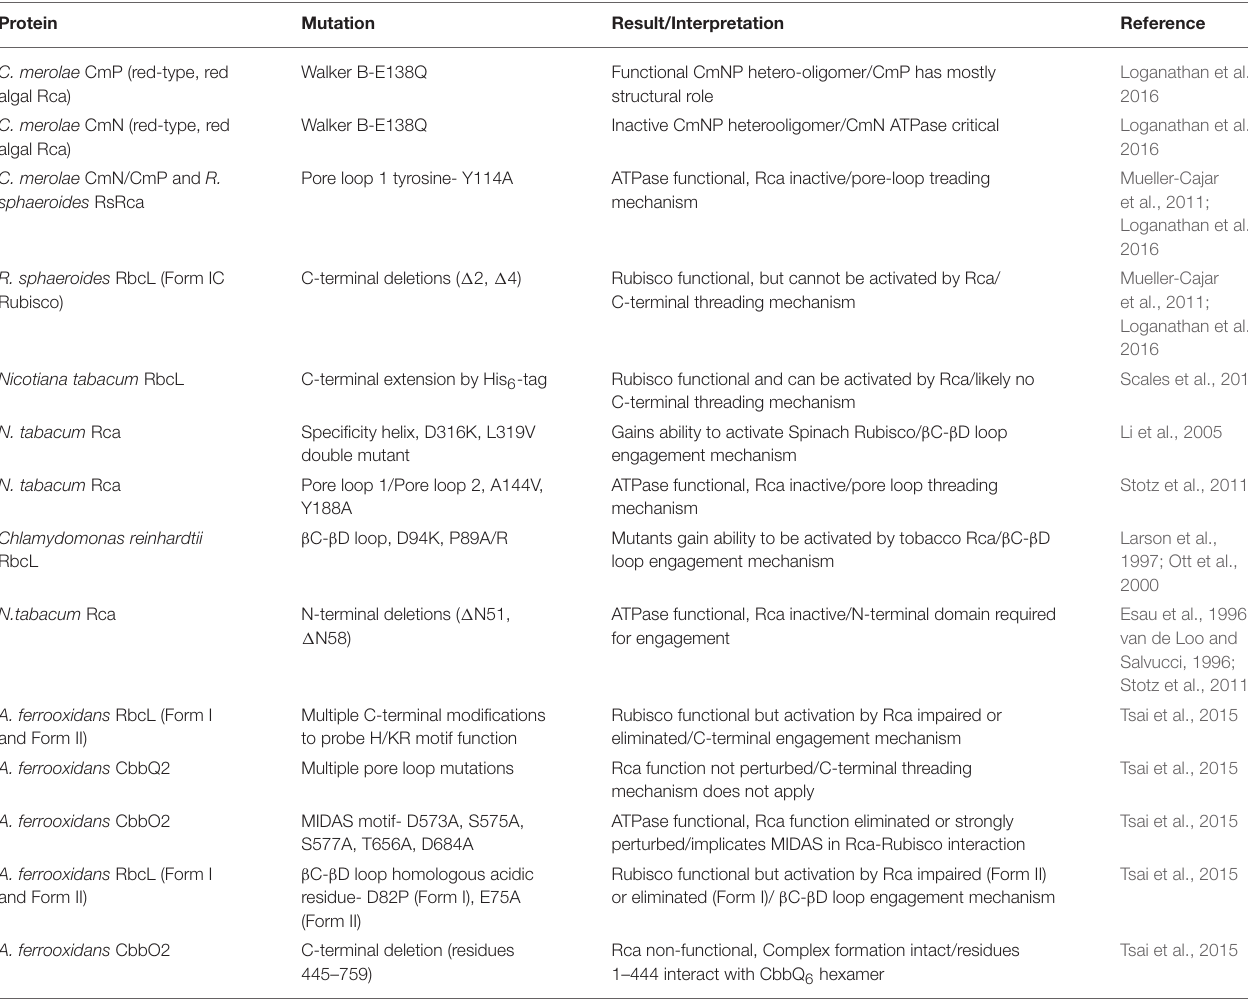
TABLE 1 | Overview of selected key Rca and Rubisco mutants providing insights into the activation mechanism and listed in the order referred to in the